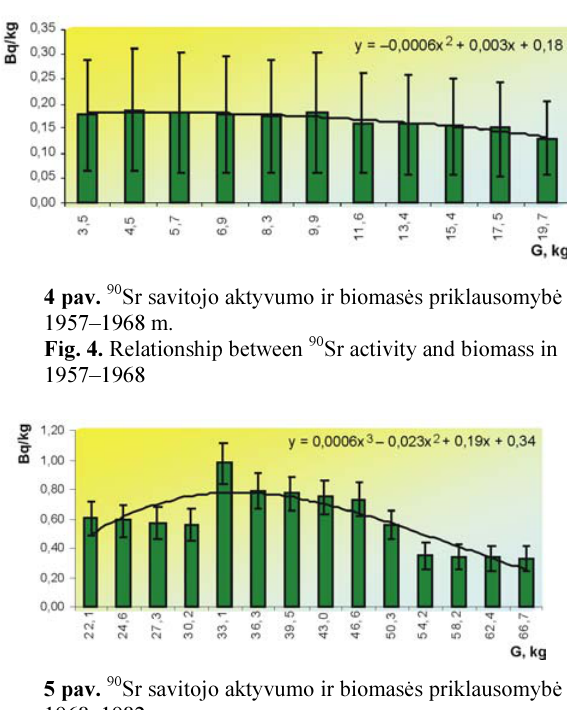
90 Sr activity and biomass in